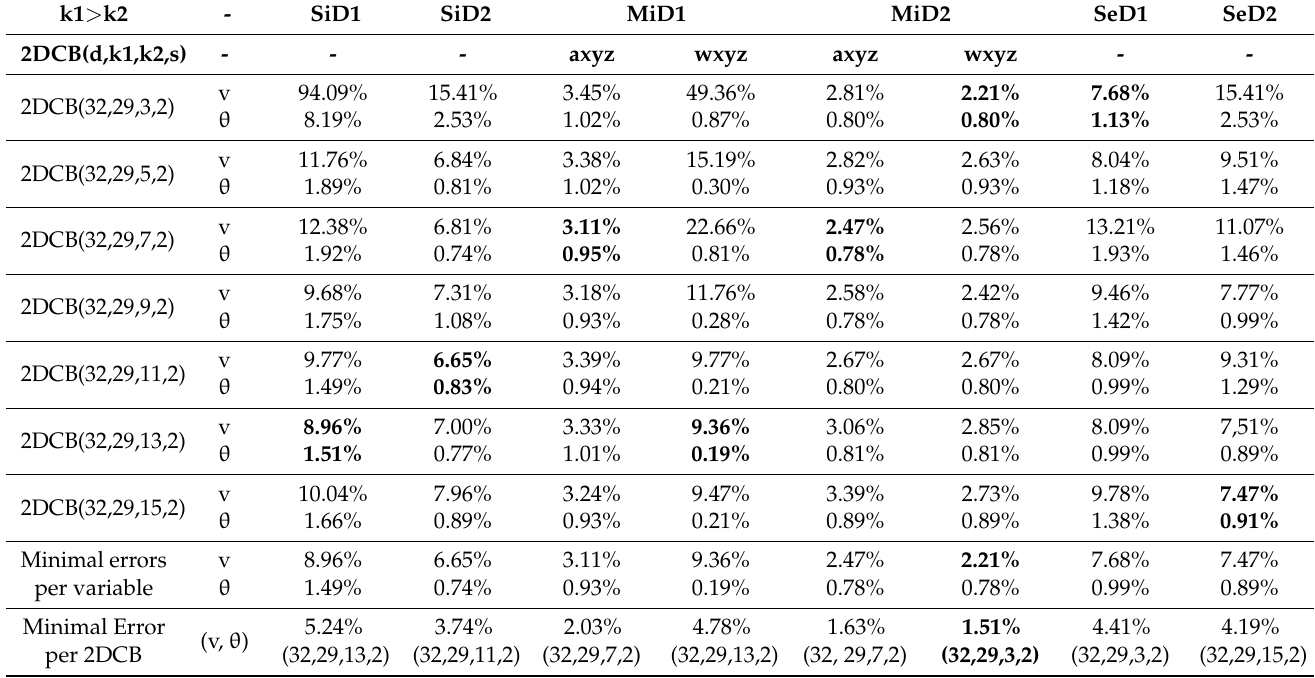
Table 5. MAPE obtained during the 2DCB optimization k1 > k2 for the architectures. Bold texts show the best